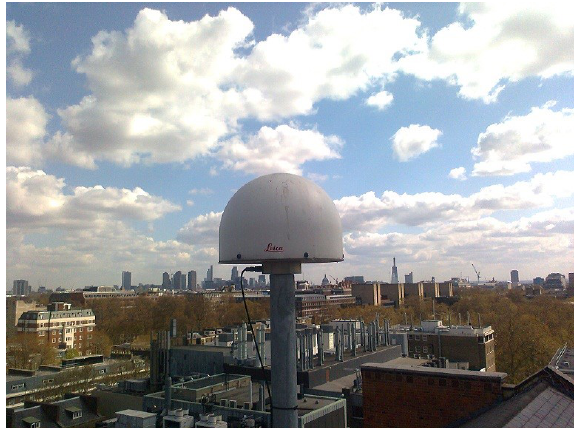
Figure 2: Antenna of the Leica SmartNet station UCL.